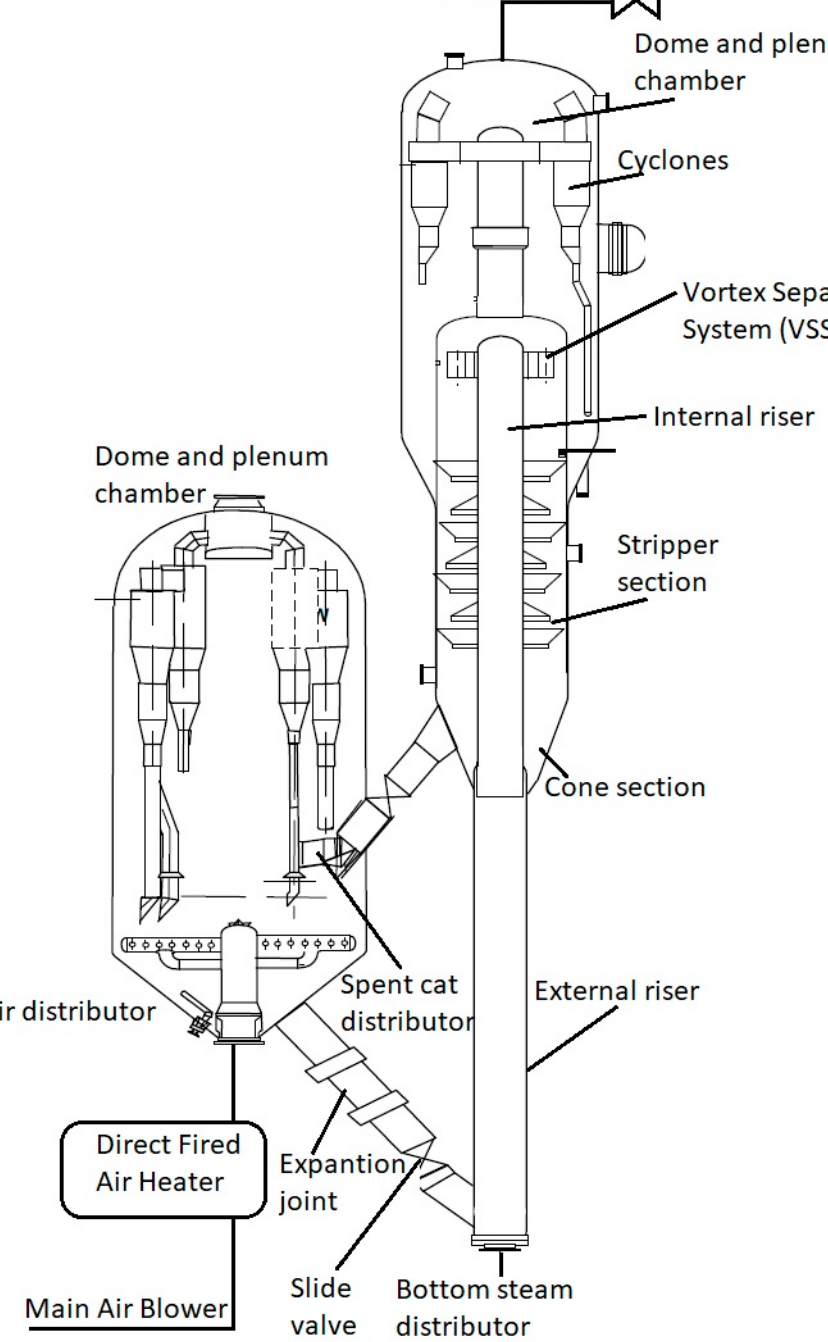
Figure 2. A diagram of reactor–regenerator section of the FCC unit, whose parts shown with inscriptions were revamped.